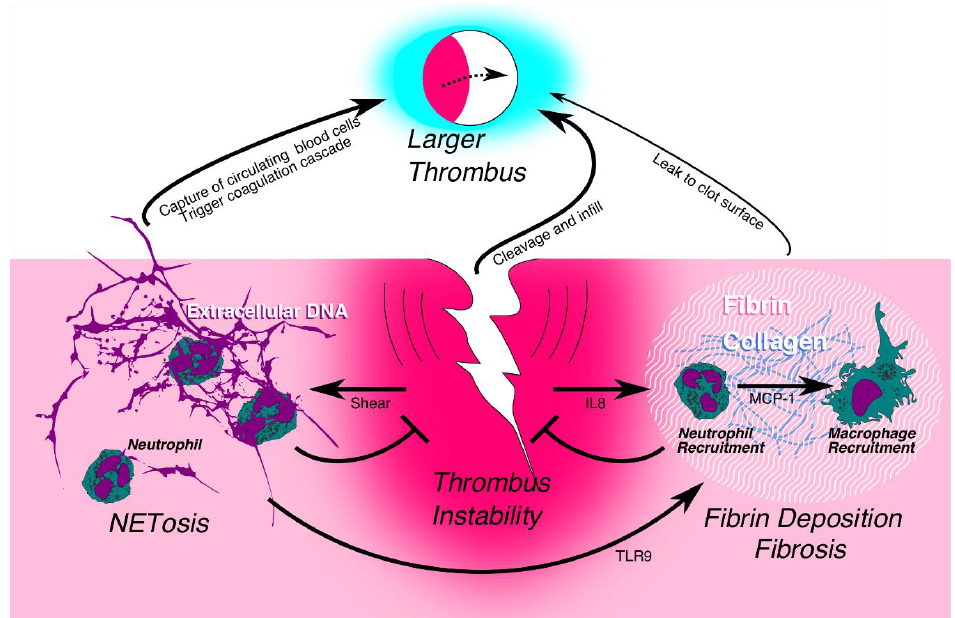
Figure 2. Proposed mechanism of early thrombus resolution involving neutrophils (PMNs). NETosis and fibrosis are distinct mechanisms for increasing thrombus stability and may prevent embolization.